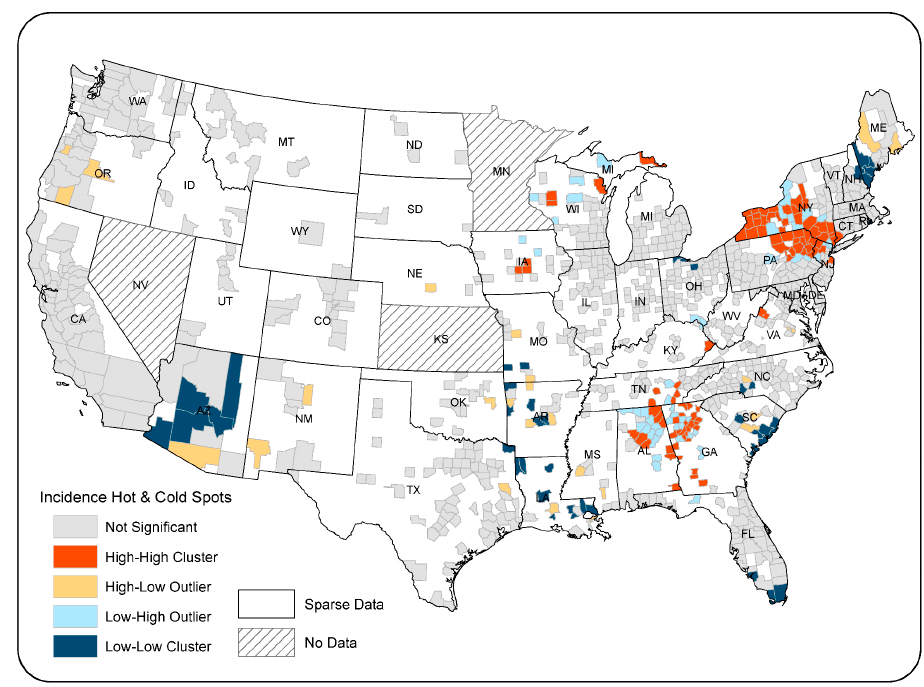
Figure 2. Local indicator of spatial autocorrelation (LISA), county-level ovarian cancer incidence 2009–2013, whites.